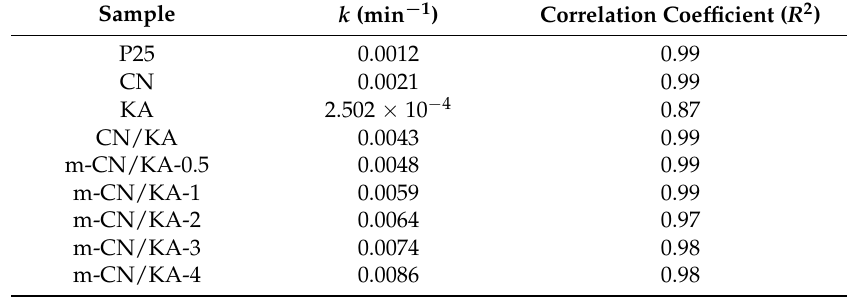
Table 2. Parameters of the pseudo-first order for RhB degradation under visible light over P25, CN, KA, CN/KA, and m-CN/KA composites with various modifier amounts.